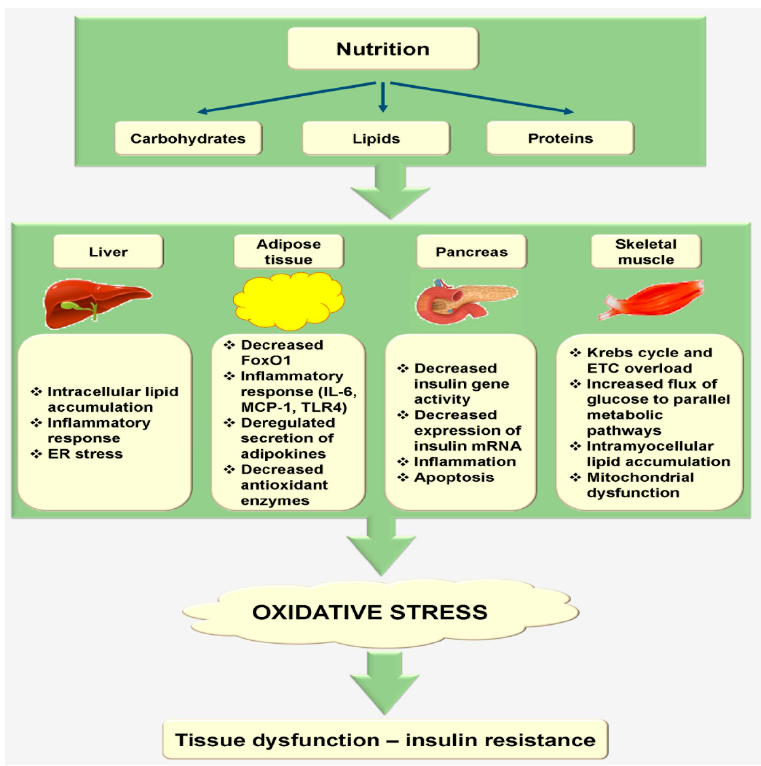
Figure 2. Nutrition mediates oxidative stress at the metabolic tissue level. Dietary fat (lipids) induces intracellular lipid accumulation in the liver and subsequently causes the inflammatory response